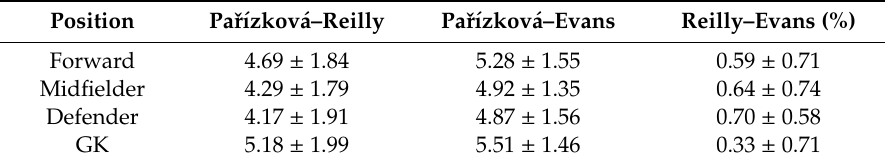
Table 4. Mean di ff erence between equations used to calculated %BF by player